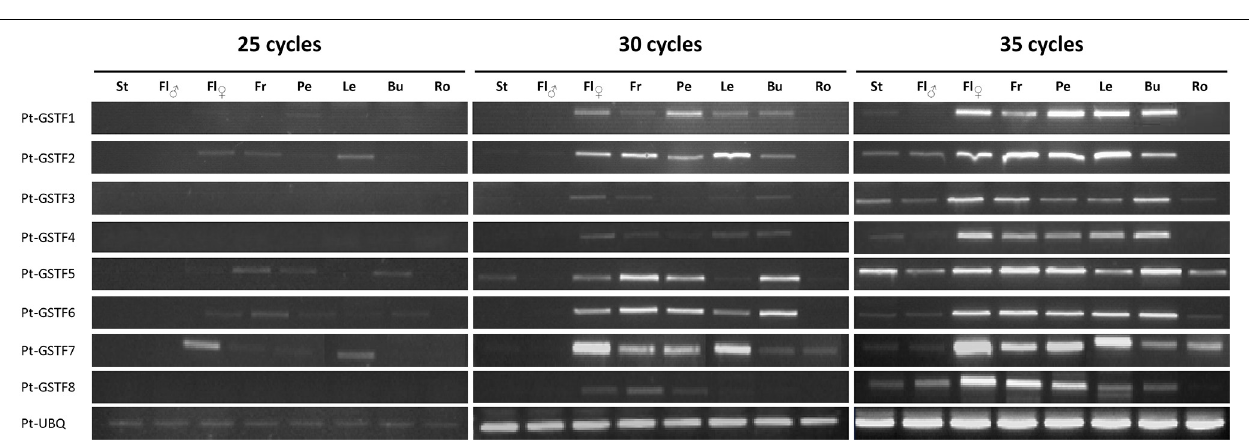
order to test the robustness of the tree. The scale marker represents 0.05 substitutions per residue. Sequence names have been removed for clarity but all sequences used are available as Supplementary Table S1. For each major branch, the consensus active site signature containing the catalytic residue is indicated, x is used when the variability is too high. P. trichocarpa isoforms have been indicated by an arrow on the tree (F1–F8).